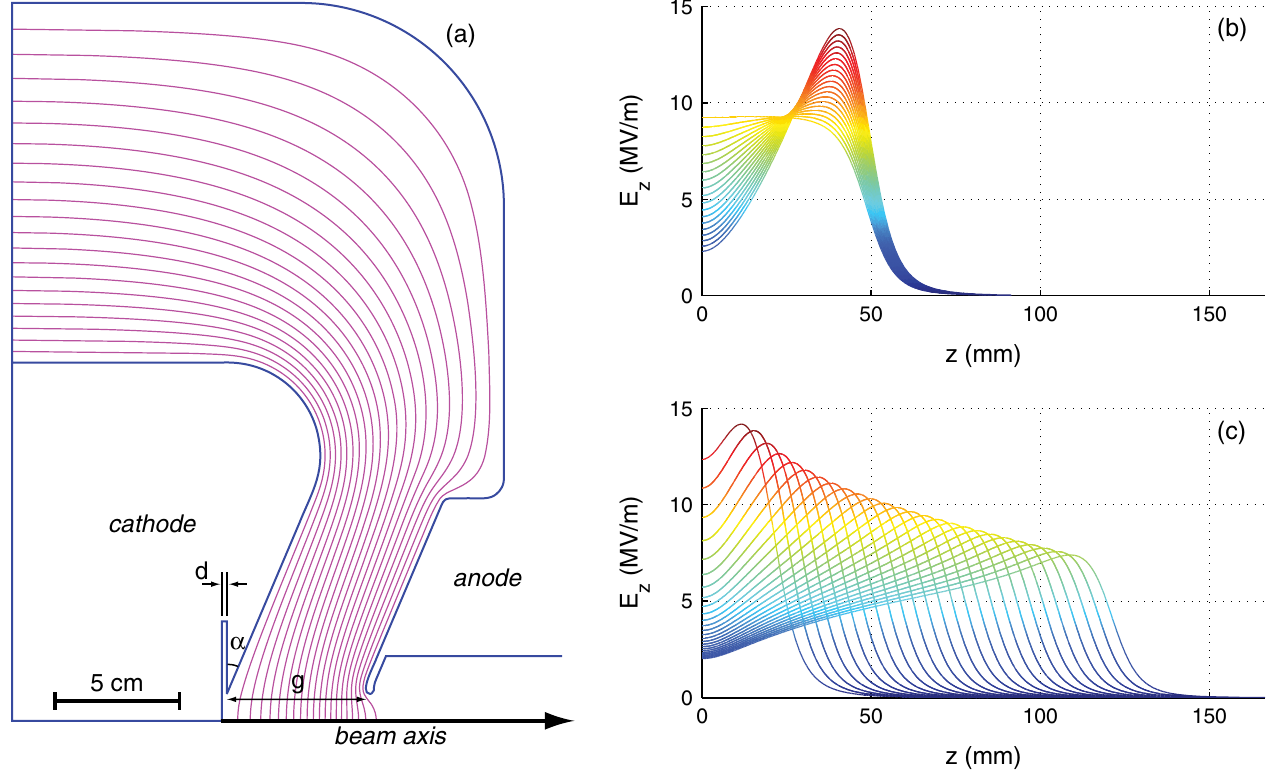
FIG. 1. (a) The parametrized dc gun geometry: the electrode angle (cid:2) , the cathode-anode gap g , and the photocathode recess d are the parameters varied by the optimizer. Equipotential lines are shown. (b) The effect of varying the angle (cid:2) (from 0 to 45 (cid:4) ) on the axial electric field for a fixed gap g ¼ 48 mm . (c) The effect of varying the gap g (from 20 to 120 mm) for a fixed (cid:2) ¼ 23 (cid:4)